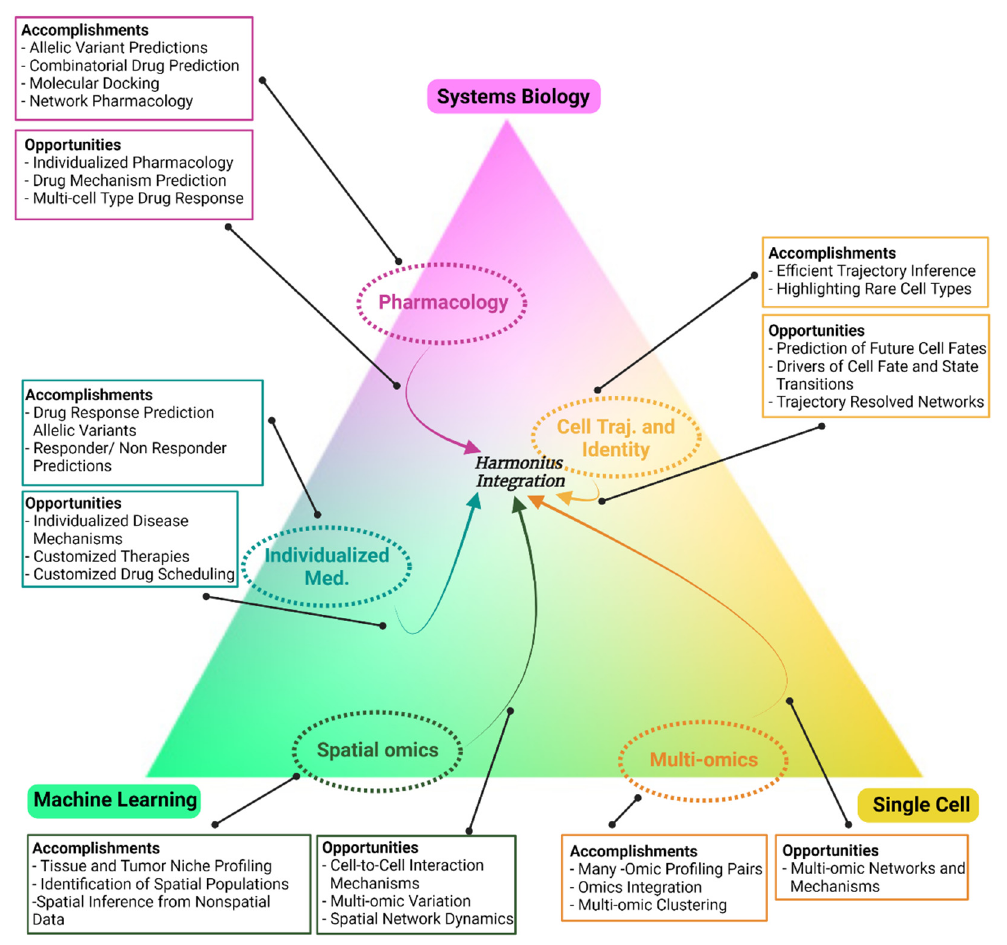
Figure 2. The success and opportunities of key fields within the trifecta. The current degree of integration of each key research areas with single-cell data, systems biology, and machine learning. Integration is represented by ovals’ proximity to each corner of the trifecta. The center represents equal and wholistic integration, which we suggest will be of great utility. Accomplishments and opportunities in each key field are listed in the matching colored boxes. (Created with Bio- Render.).